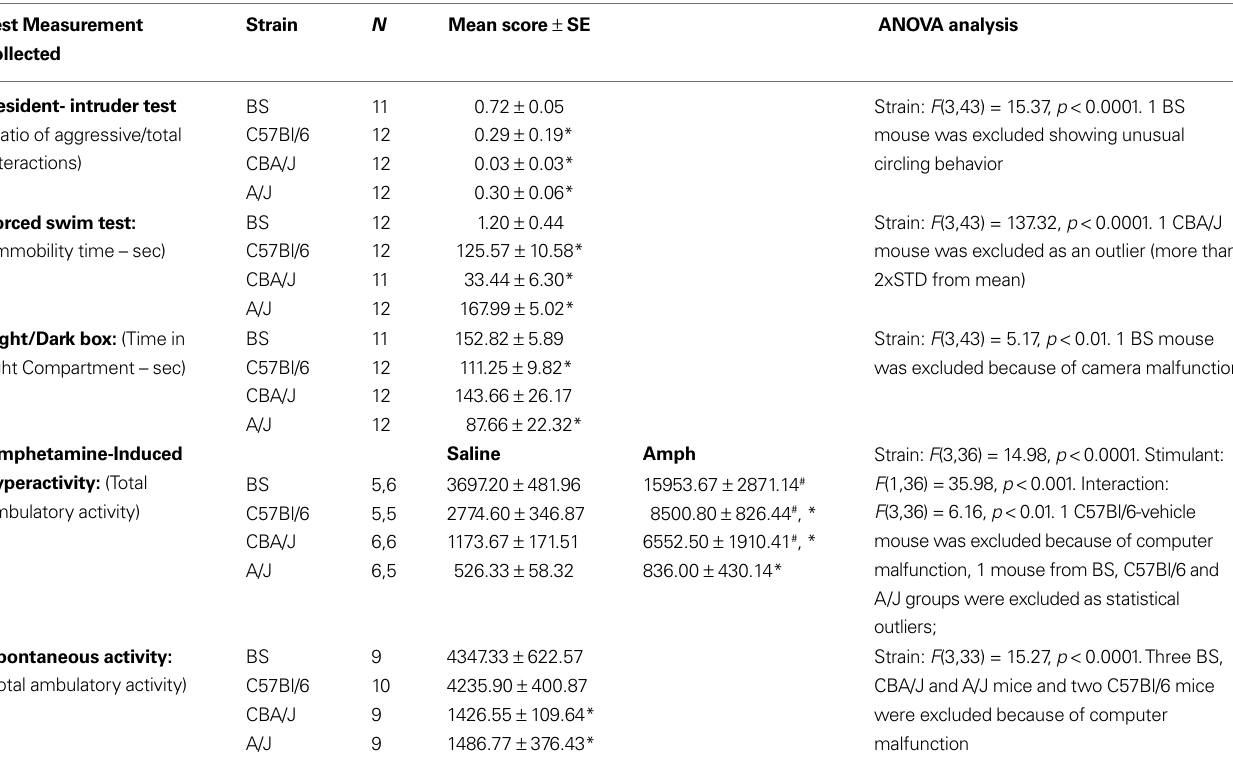
Table 1 | Strain differences in tests for domains of